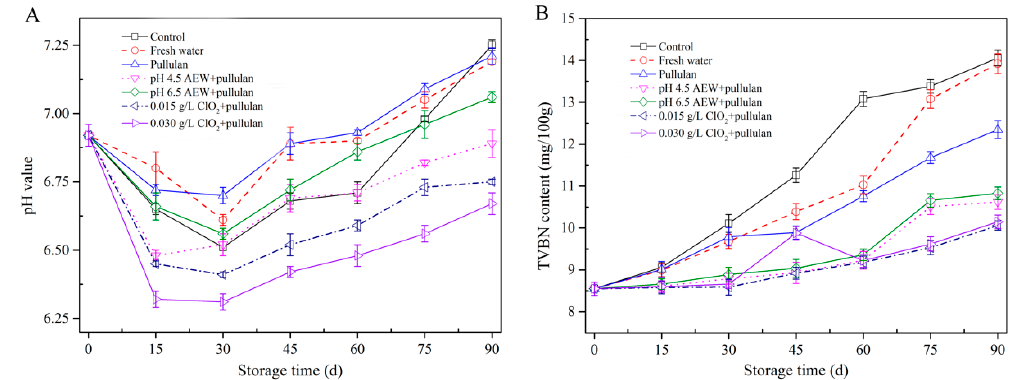
Figure 4. pH value ( A ) and TVBN content ( B ) of half-shell mussels treated with the control, water, and combined glazing solutions during 90 days of frozen storage.